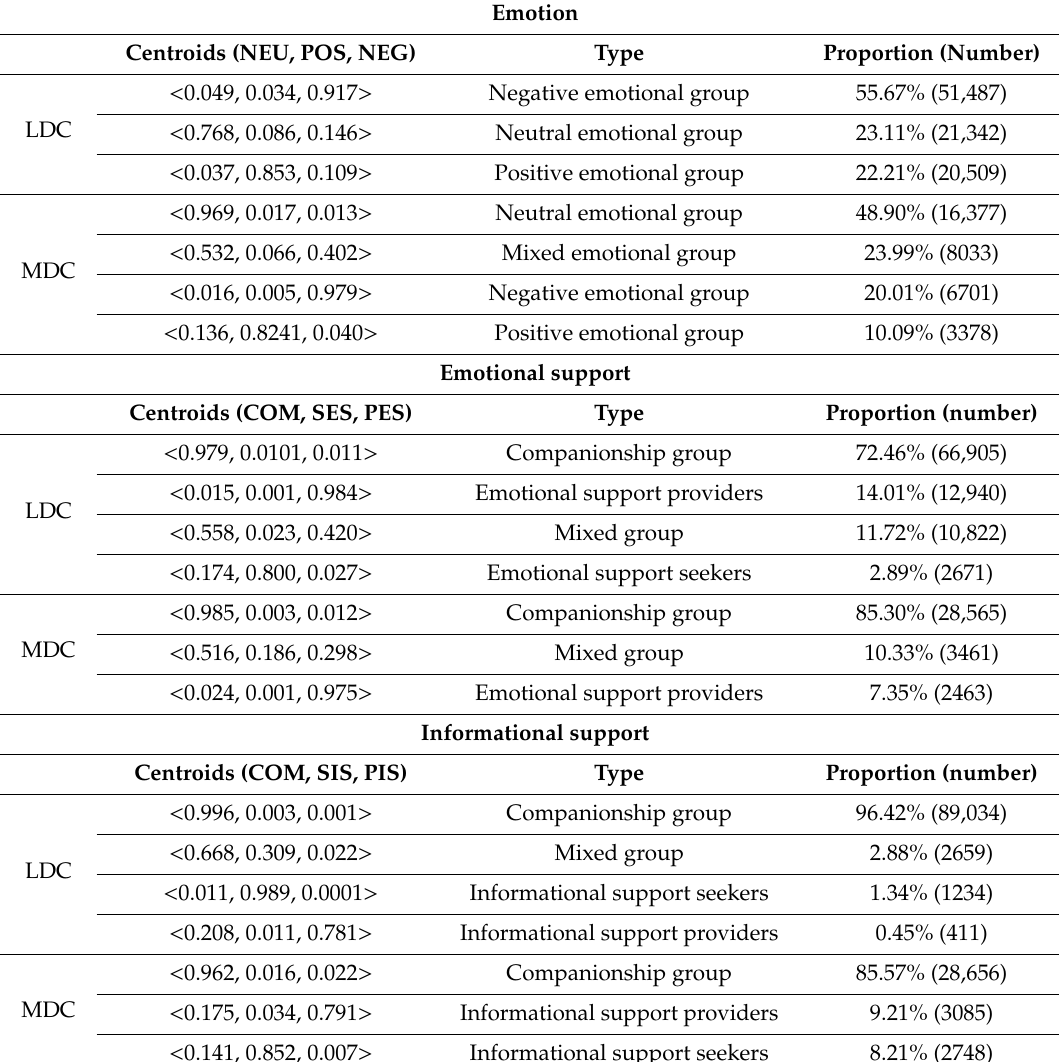
Table 3. Clustering results and proportion of groups in each